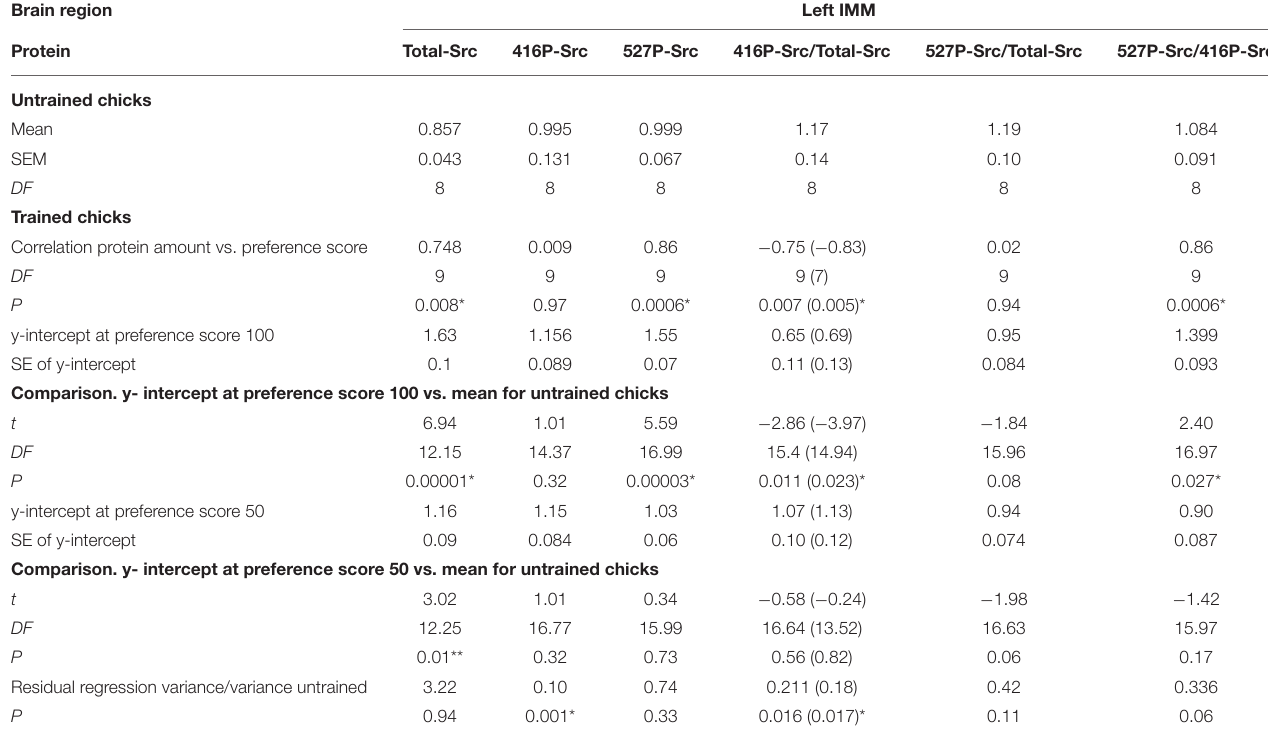
TABLE 2 | Standardized relative amount of protein. Brain